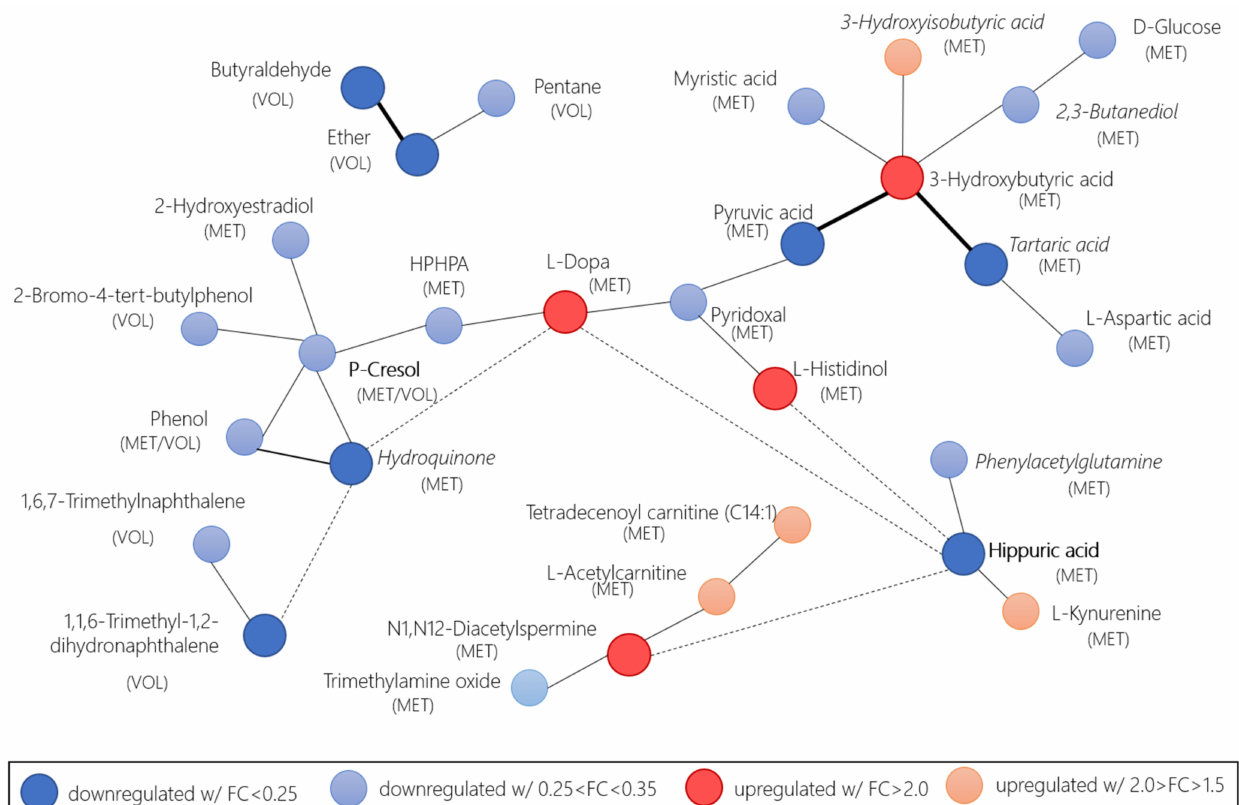
Figure 6. Network of relevant compounds in the comparison of CRC and adenomas versus control and CRC pre- and post-surgery, calculated by the weighted p-value and fold-change with MetaMapp biochemical mapping. Red nodes of upregulated compounds with FC > 2.0 (dark red) and 2.0 > FC > 1.5 (light red). Blue nodes downregulated with FC < 0.25 (dark blue) and 0.25 < FC < 0.35 (light blue). Thicker edges indicate that the relevant compounds are found in the volcano plot with log2FC above/below +2.0/ − 2.0. Dashed edges indicate that they are only reported for the log2FC above/below +2.0/ − 2.0 compounds. Bold names indicate compounds found in both the case-control and pre-/post-surgery groups. Compounds in the cursive were only found in the pre-/post-surgery group. HPHPA is the 3-(3-Hydroxyphenyl)-3- hydroxypropanoic